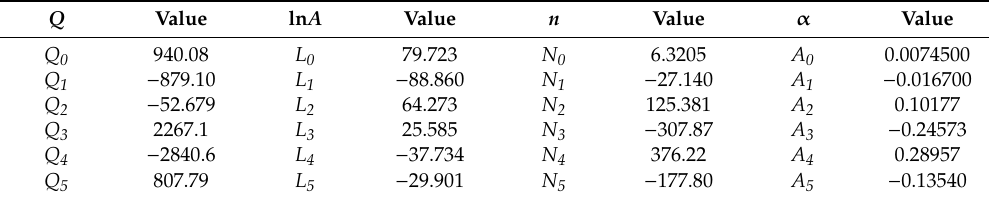
Table 1. Polynomial fit results of Q , ln A , n , and α of the PM / Wrought dual superalloy.